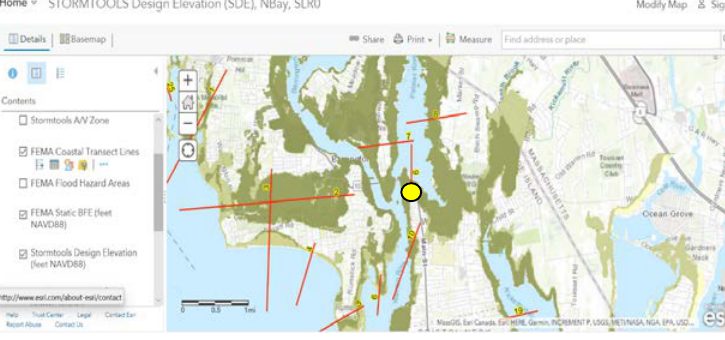
Figure 14. Comparison of SDE (upper panel) vs. FEMA (lower panel) BFE maps for the 100-yr, no-SLR case. The FEMA transect lines are shown in the FIRM maps.